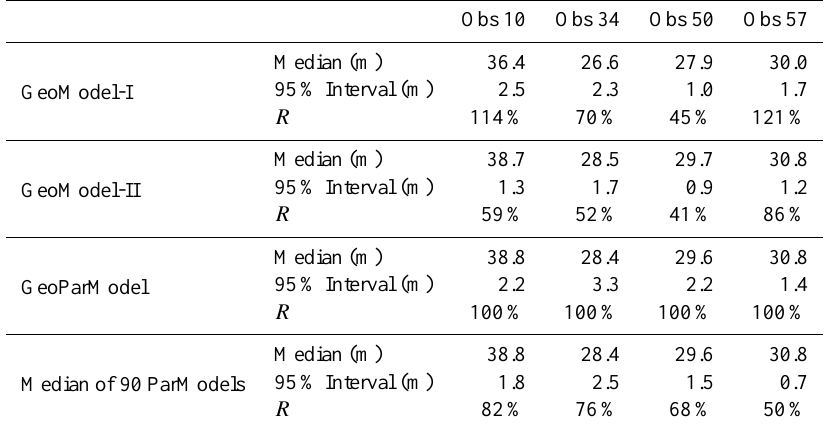
Fig. 9. Histogram of travel time of four wells for GeoModel-I (left column), GeoModel-II (middle column) and GeoParModel (right column). The green line indicates the mean value and the red line represents the median value. Table 4. Simulated heads for four observation points for GeoModel-I, GeoModel-II, GeoParModel, and the median of 90 ParModels. R denotes the fraction of the 95% confidence interval to the one from GeoParModel. Location of the four points is shown in Fig. 1. Obs